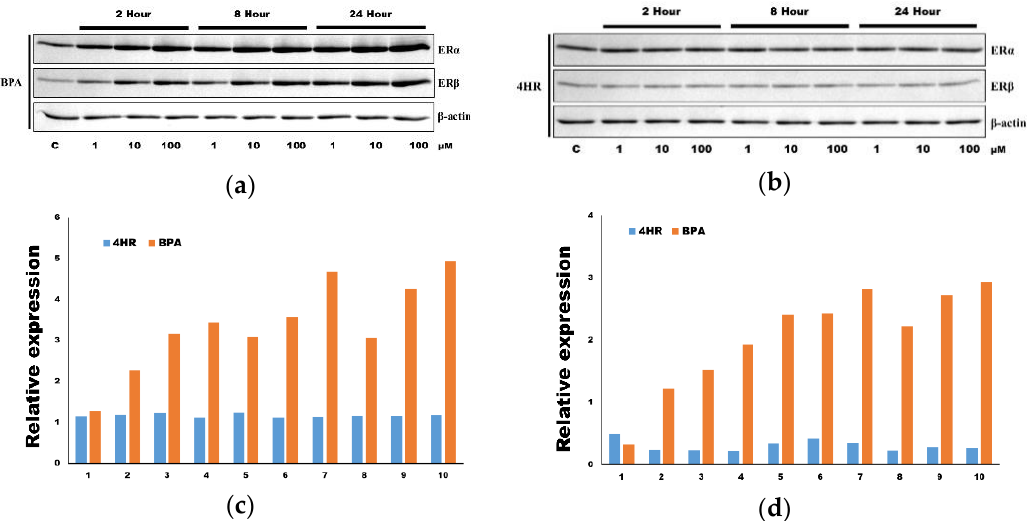
Figure 2. The expression of estrogen receptors after the administration of BPA or 4HR. ( a ) The application of BPA (1 to 100 µ M) to MCF-7 cells increased the expression of ER α and ER β . ( b ) The application of 4HR (1 to 100 µ M) to MCF-7 cells did neither increase nor decrease the expression of both ER α and ER β . ( c ) Relative protein expression of ER α to β -actin. The application of BPA increased relative expression level of ER α compared to that of 4HR. ( d ) Relative protein expression of ER β to β -actin. The application of BPA increased relative expression level of ER α compared to that of 4HR. Full length blots were available in Supplementary Fig. 1 and 2.